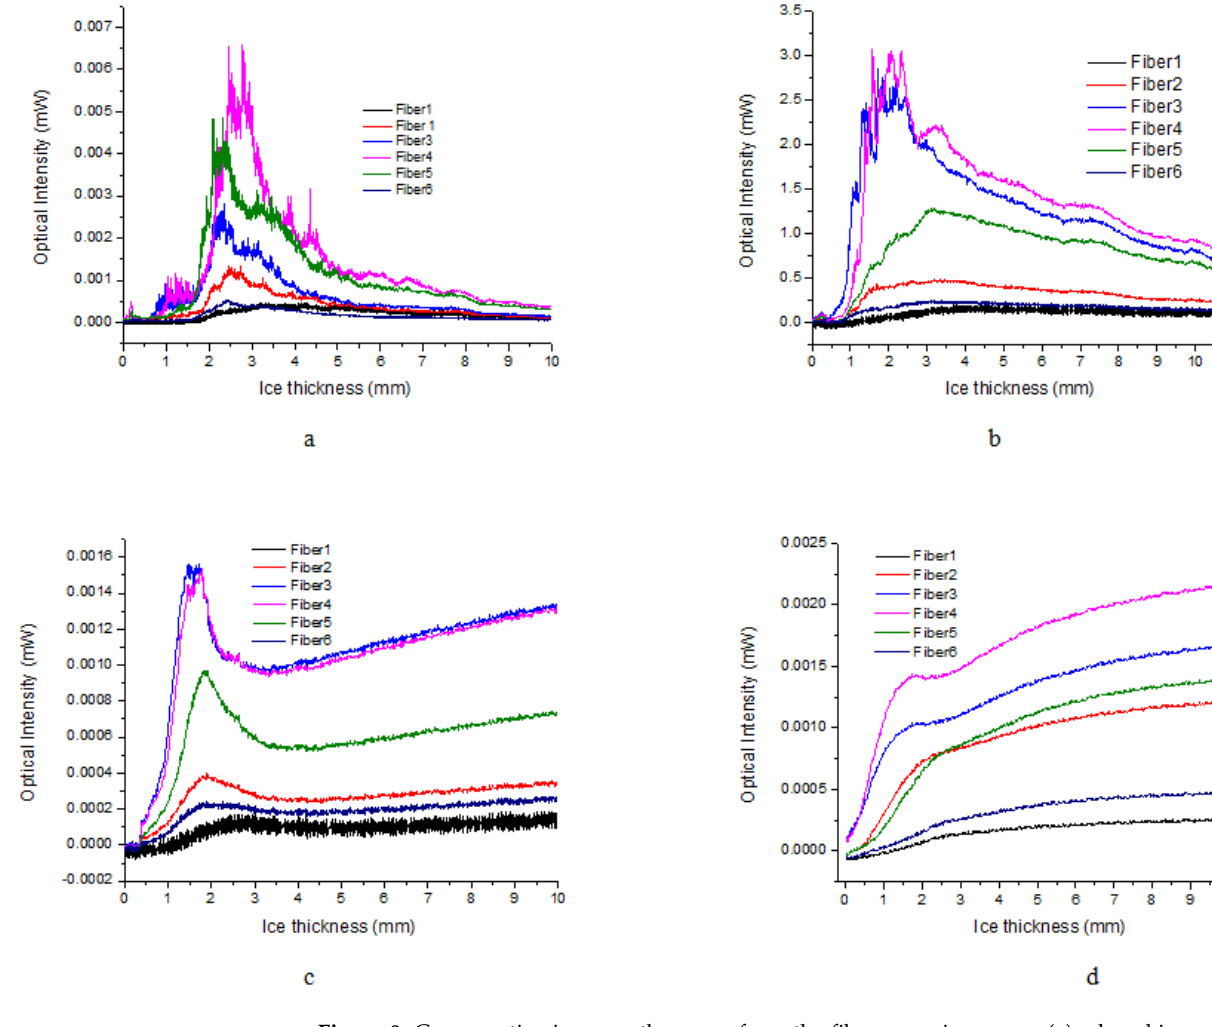
Figure 9. Comparative ice growth curves from the fiber array ice sensor ( a ), glazed ice accreted at − 5 °C to − 7 °C ( b ), for mixed phase ice accreted at − 10 °C to − 15 °C ( c ), nearly rime ice accreted at − 20 °C ( d ), and totally rime ice accreted at − 25 °C.